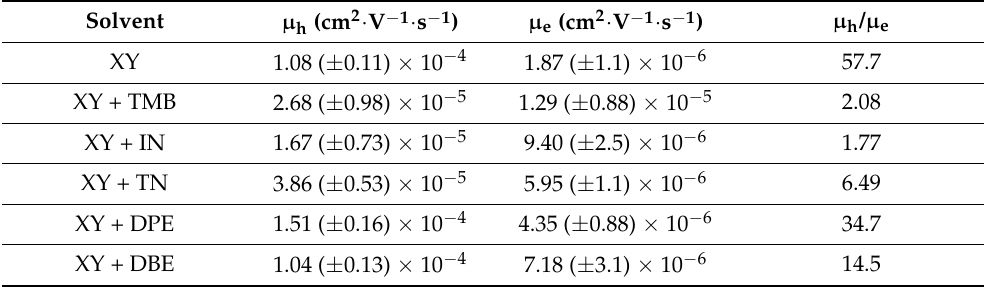
Table 3. Summary of hole mobility ( µ h ) , electron mobility ( µ e ), and the ratio of hole and electron mobilities ( µ h / µ e ) of XY- and XY + additive-based